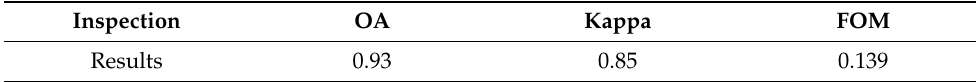
Table 2. FLUS model validation results.